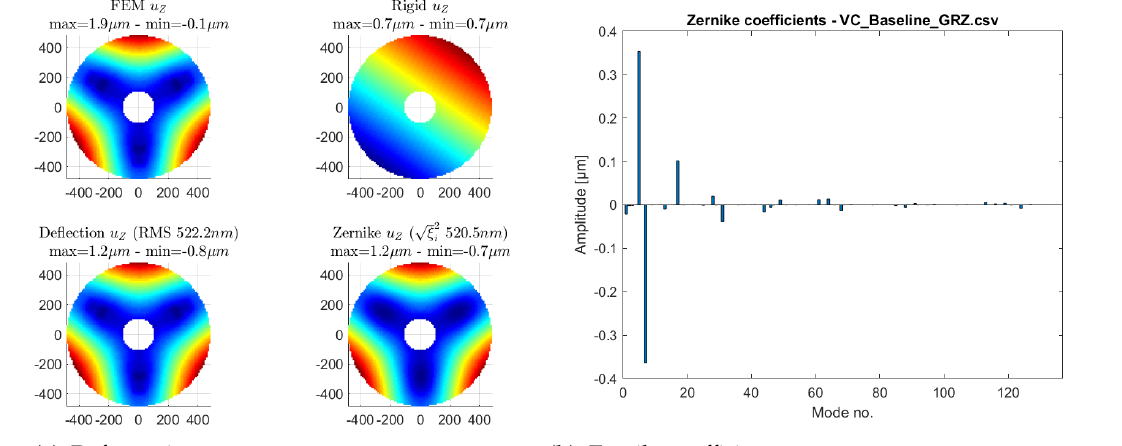
Figure 8. Baseline design with out-of-plane loading and inside support.